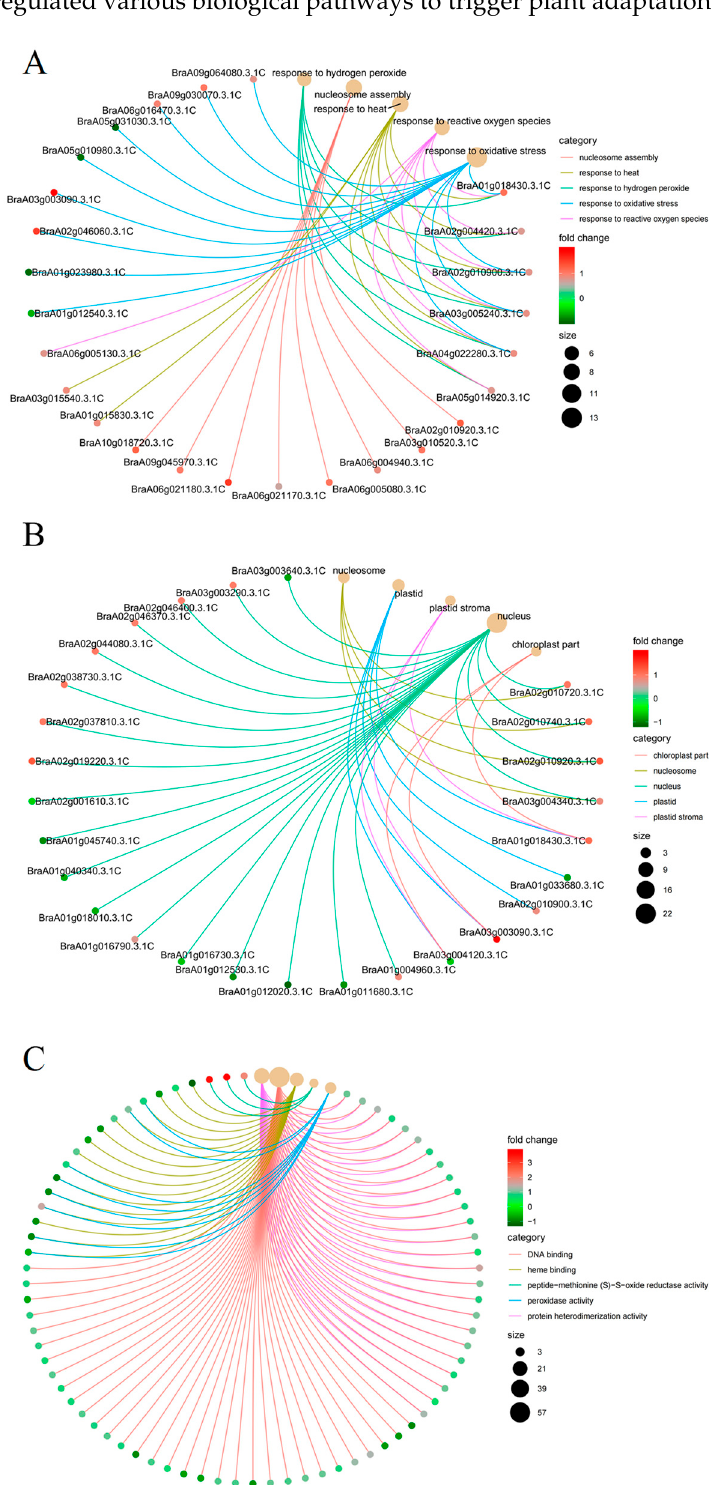
Figure 5. GO enrichment analysis. ( A ) BP, biology process; ( B ) CC, cell component; ( C ) MF, molecular function. The size and color of the point indicates the number of differentially expressed genes in the pathway and the fold change as the threshold for signi fi cantly di ff erential expression, respectively.